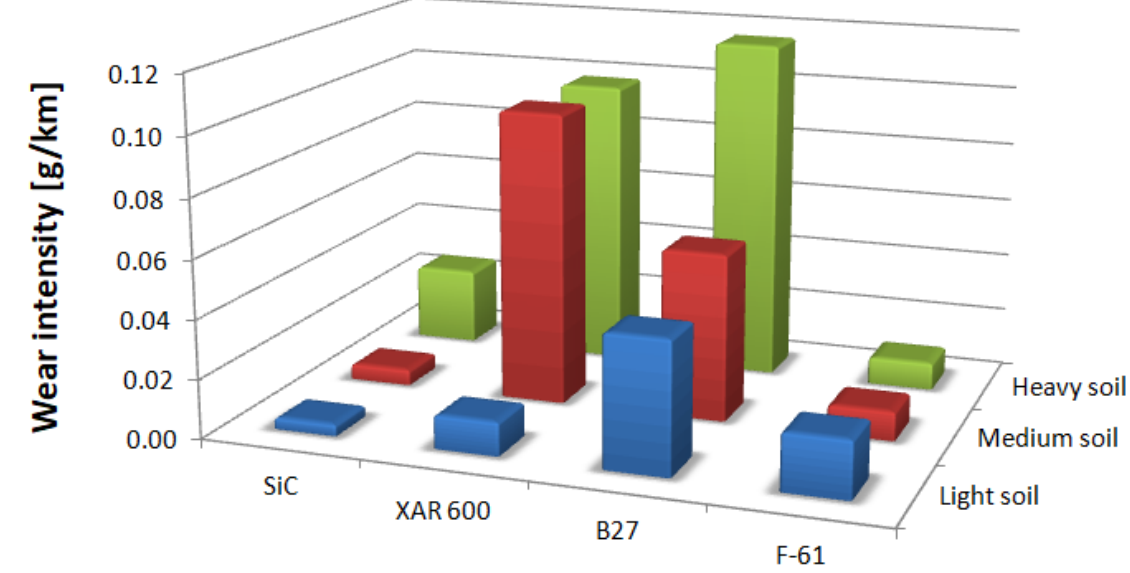
Figure 10. Unit wear of tested materials in individual soils.